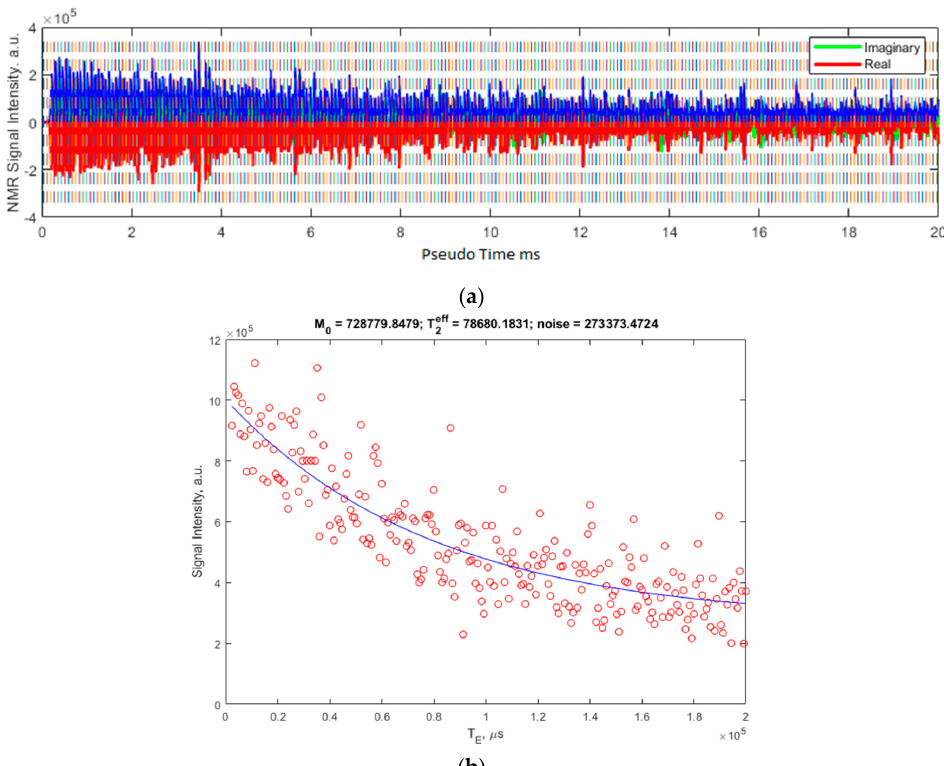
Figure 4. ( a ) shows the raw signal as collected using the MATLAB GUI. The blue overlay is the modulus of the real (red) and imaginary (green, mostly overlaid) channels of the acquisition. ( b ) shows the resulting integrals of these echoes in red and the fit to this data, the parameters of which are shown above the plot. The T 2eff is shown in microseconds.